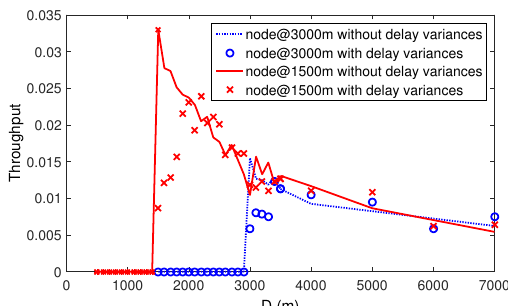
Figure 3. Impact of the large-scale and the small-scale delay variations on throughput of Slotted-FAMA. The throughput is obtained according to Equation